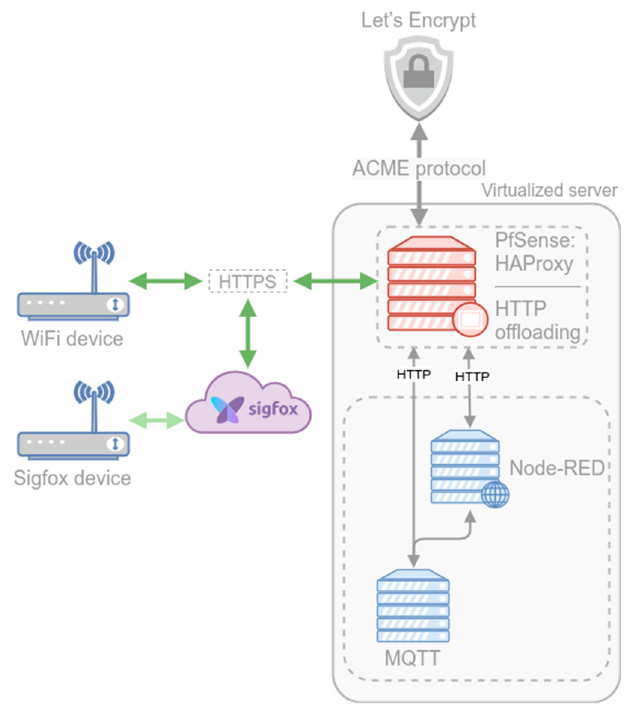
Figure 7. Secured communication schema.